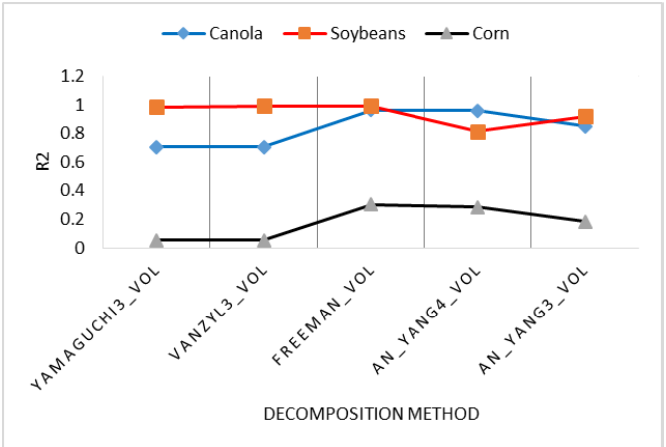
Figure 4. Plot of RMSE decompositions method and ground